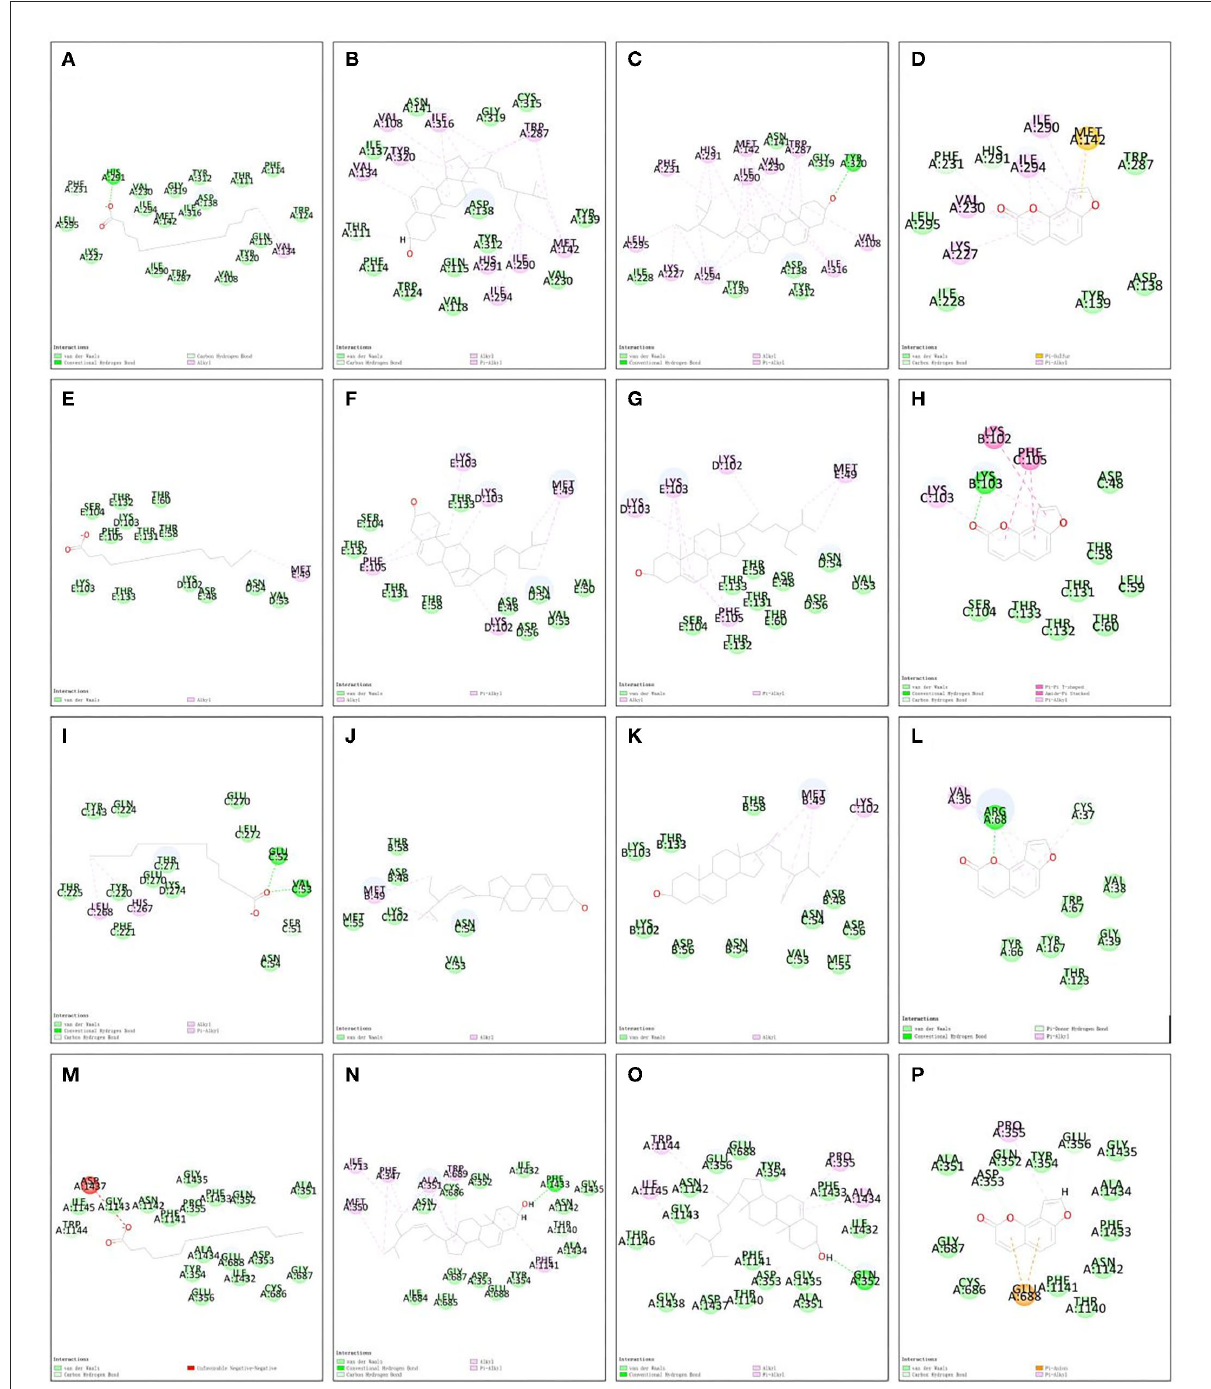
FIGURE8 Molecular docking 2D models. (A) OPRK1-hexadecanoic acid complex. (B) OPRK1-stigmasterol complex. (C) OPRK1-beta-sitosterol complex. (D) OPRK1-angelicin complex. (E) GABRA5-hexadecanoic acid complex. (F) GABRA5-stigmasterol complex. (G) GABRA5-beta-sitosterol complex. (H) GABRA5-angelicin complex. (I) GABRP-hexadecanoic acid complex. (J) GABRP-stigmasterol complex. (K) GABRP-beta-sitosterol complex. (L) GABRP-angelicin complex. (M) SCN3B-hexadecanoic acid complex. (N) SCN3B-stigmasterol complex. (O) SCN3B-beta-sitosterol complex. (P) SCN3B-angelicin